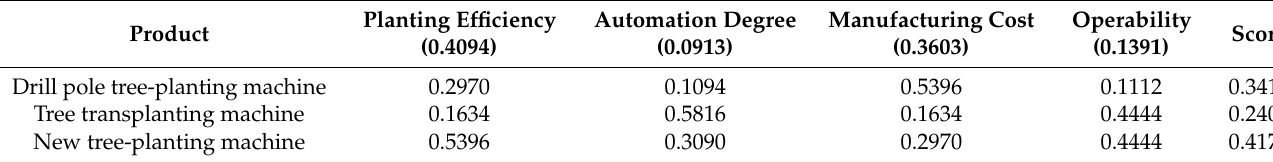
Table 9. Evaluation list of tree-planting